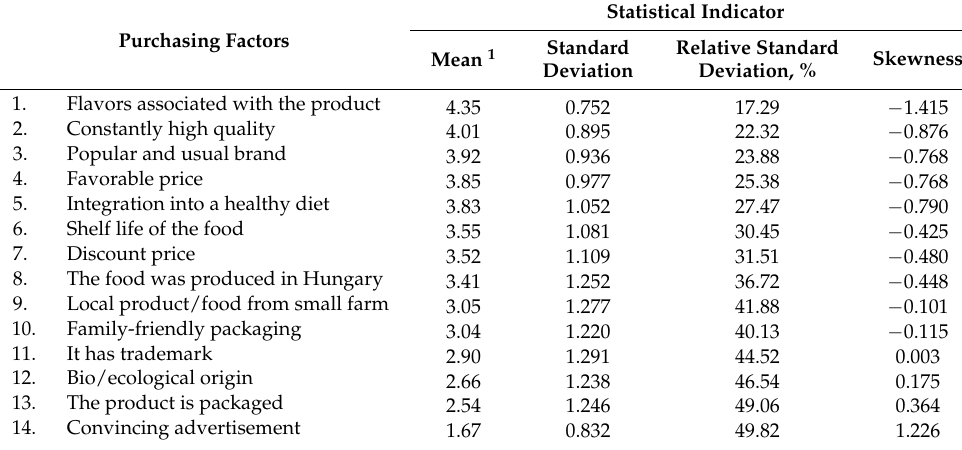
Table 3. Importance of purchasing factors when buying food before coronavirus (N = 3000).